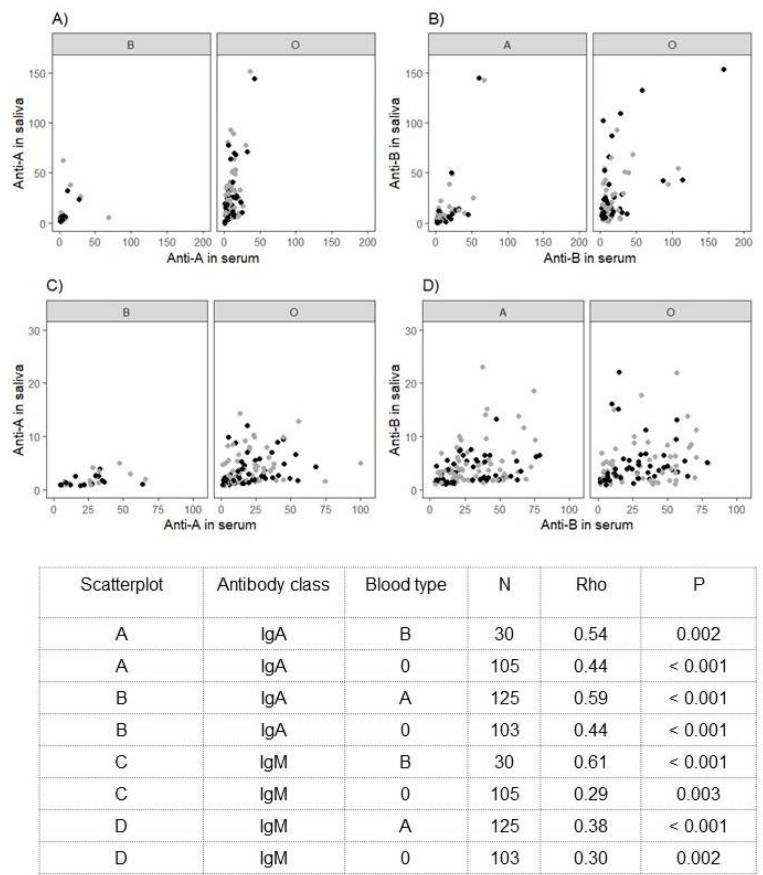
Figure 3. ( A – D ). Correlation of ABO antibodies in the serum and saliva of COVID-19 convalescents. Scatterplots A and B for class IgA; scatterplots C and D for class IgM; note that observations at visits 1 and 2 are gathered together. N, number of individuals.